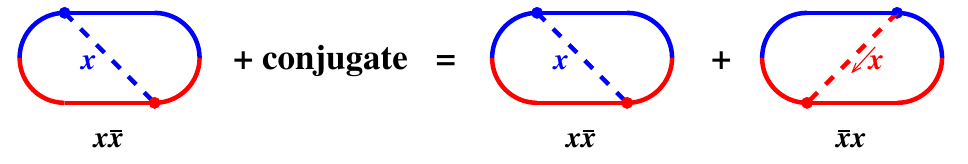
Figure 3 . Time-ordered diagrams for the leading-order rate for single gluon splitting. [26]. momentum fractions of the three (cid:12)nal-state gluons as x , y ,